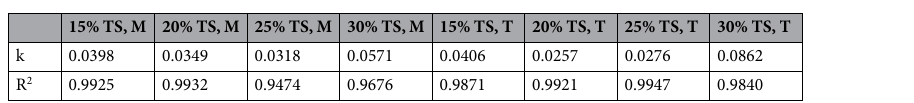
Table 3. Rate constant obtained from first order kinetic model. M – Mesophilic; T –